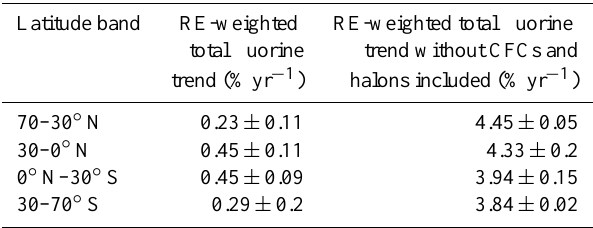
Fig. 3. The mean percentage contribution of ACE-FTS (black) and Figure 3: The mean percentage contribution of ACE-FTS (black) and SLIMCAT (red) to the SLIMCAT (red) to the total fluorine VMR for all years between total fluorine VMR for all years between 70 ° N - 30 ° N. The error bars are the maximum or 70–30 ◦ N. The error bars are the maximum or minimum single con- minimum single contribution to the total fluorine percentage from these years. tribution to the total fluorine percentage from these years.